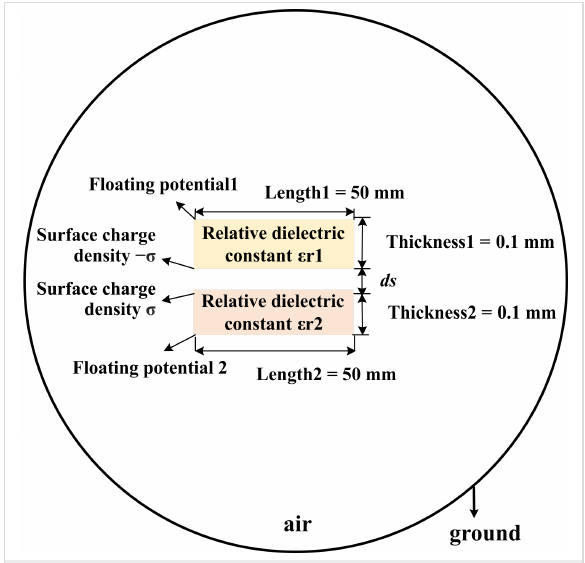
Figure 2: Two-dimensional model of a contact separation TENG.